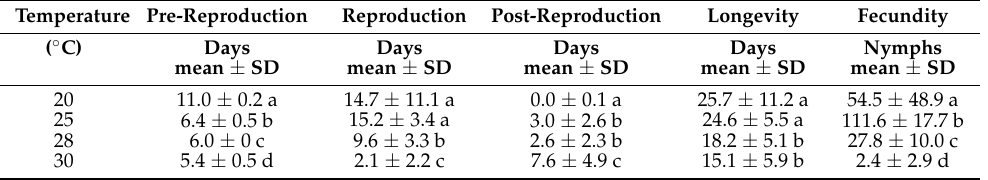
Table 1. Mean developmental time, longevity, and fecundity of Phorodon cannabis at different temper- ature regimes ( n = 50). Values marked with different letters differ significantly at p < 0.05 based on the Tukey